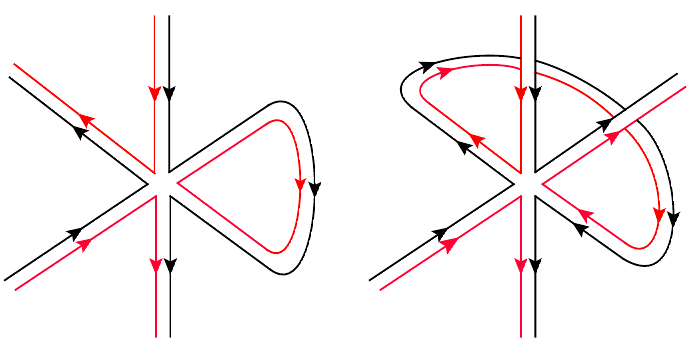
Figure 11 . Di(cid:11)erent contractions of (cid:30)(cid:30) pairs can lead to single- or multi-trace vertices. Here red lines represent (cid:13)avor indices and black lines indicate gauge